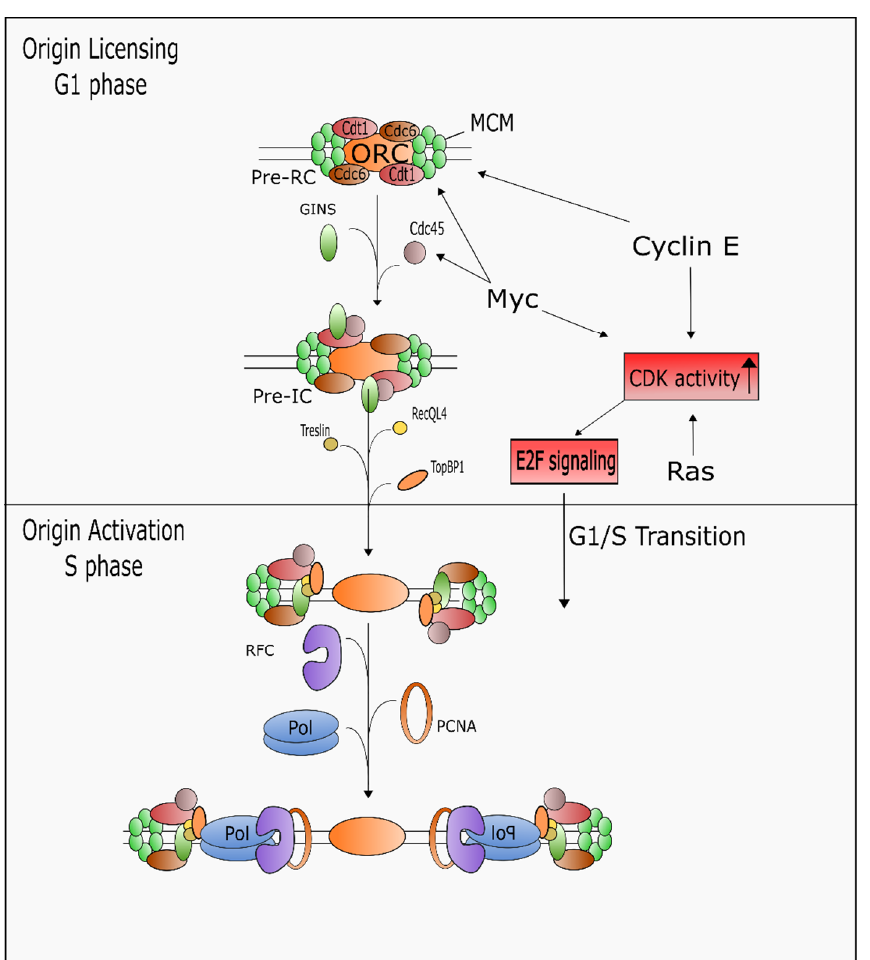
Figure 2. Oncogenes induce origin licensing and E2F transcriptional activity to drive G1/S transition and DNA hyper-replication. Myc and Cyclin E directly increase origin licensing by facilitating recruitment of pre-initiation complex (pre-IC) factors, including Cdt1, Cdc6, and MCMs. High levels of Ras, Myc or Cyclin E lead to increased CDK phosphorylation activity and E2F signaling that promotes the G1/S transition and initiation of DNA synthesis.